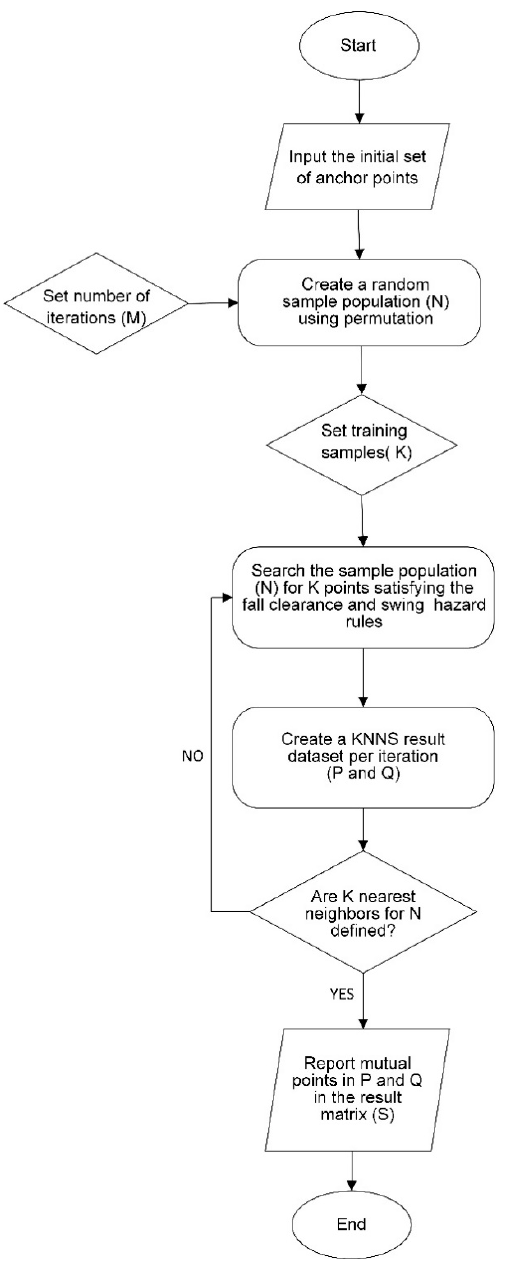
Figure 2. Algorithm for optimizing location of PFAS anchor points.